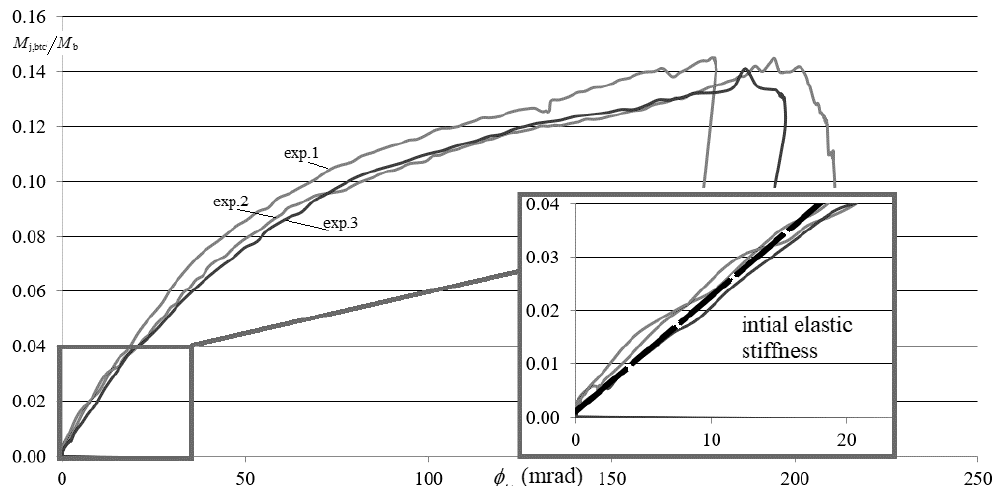
Figure 5. Relationship between the non-dimensional moment versus the rotation for beam-to-column joints and design value of the elastic stiffness.